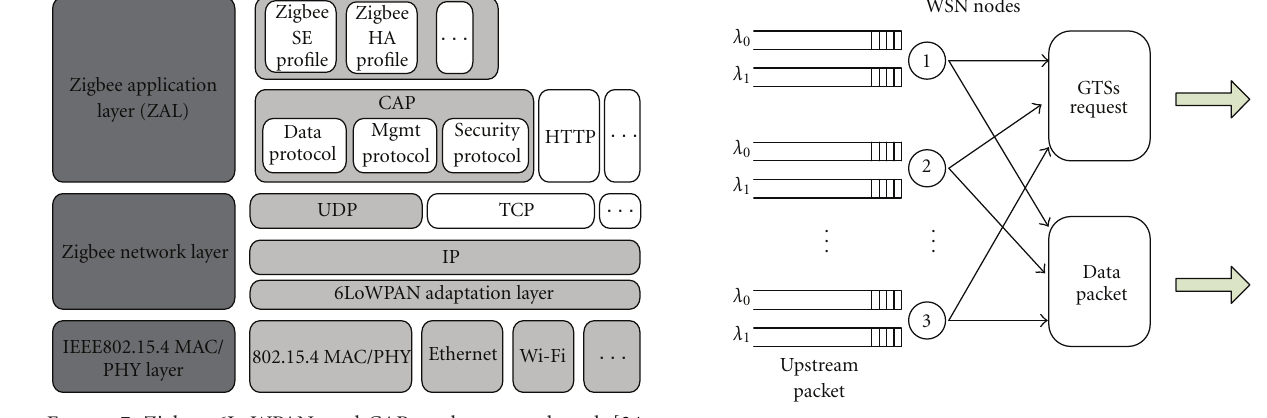
Figure 7: Zigbee, 6LoWPAN, and CAP stacks protocol stack [34, 35].